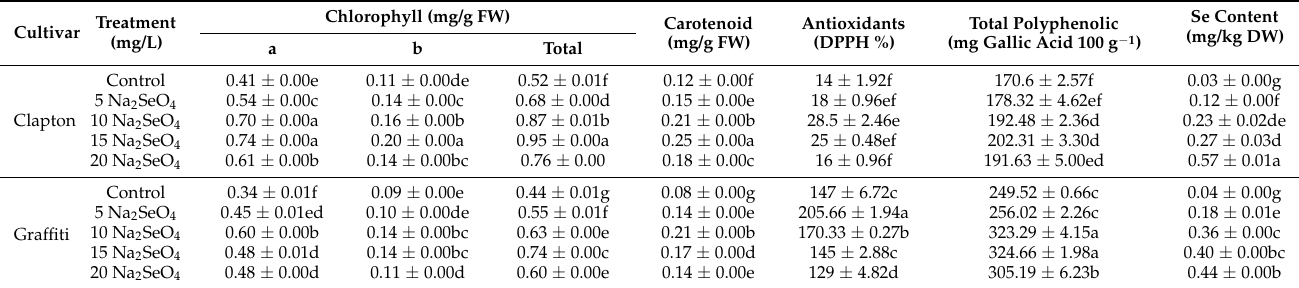
Table 3. Physiological traits of cauliflower cultivars “Clapton” and “Graffiti” after fortification with sodium selenate (Na 2 SeO 4 ). In each column, same letters are not significantly different at the1% and 5% level based on Duncan’s multiple range tests with three repetitions (Chlorophyll and Carotenoid in leaves, Antioxidants, Phenol and Se concentration in floret). Treatment Cultivar (mg/L)